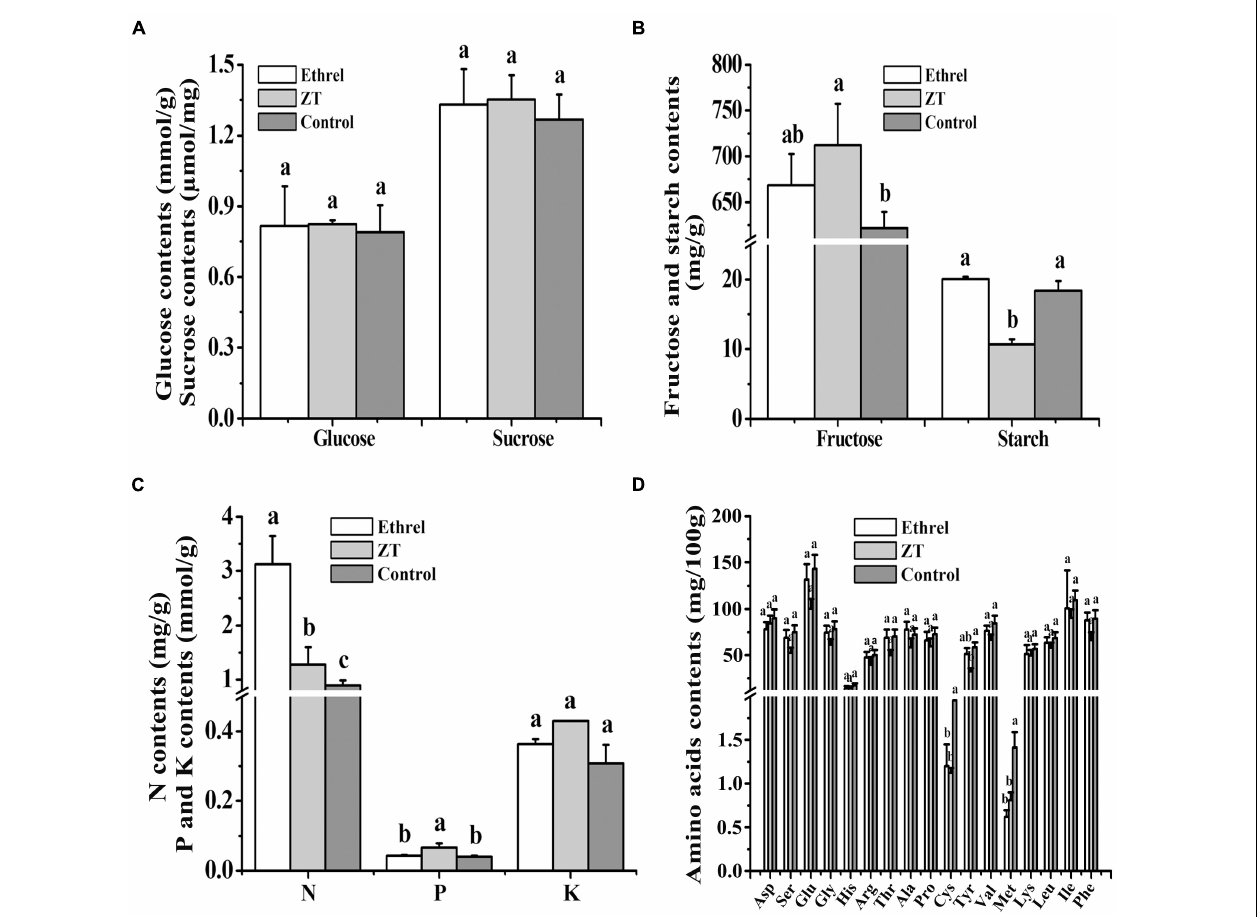
FIGURE 3 | Effects of ethrel and ZT treatments on the contents of glucose and sucrose (A) ; fructose and starch (B) ; nitrogen, phosphorus, and potassium (C) ; and amino acids (D) . Different letters denote significant differences among the treated and control groups (Tukey’s test, P <